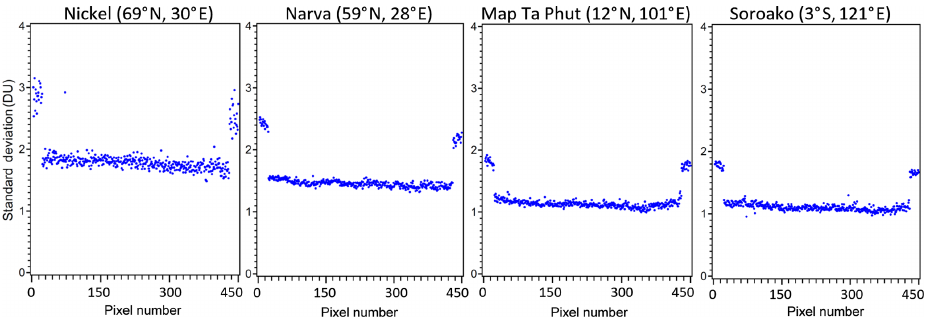
Figure 1. The SO 2 standard deviations as a function of the TROPOMI cross-track position (pixel number) at four sites illustrate a decline from high to low latitudes for the period from April 2018 to March 2019. The four sites selected represent sources with very low SO 2 emissions, and therefore the standard deviations represent the measurement uncertainties. The SO 2 values retrieved at the first and last 20 pixels have noticeably higher standard deviations and are excluded from the analysis.